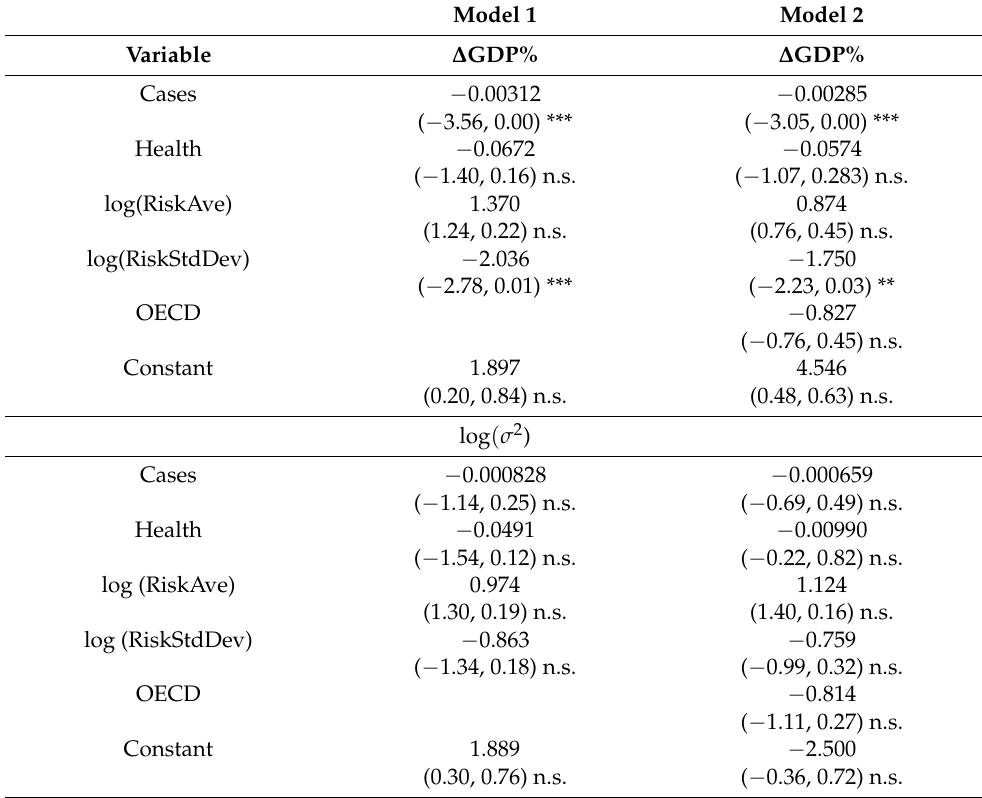
Table 5. Parameter estimate, ( t -statistic, p -value, with its significance in parenthesis), and indicators for the listed model considering heteroscedasticity with COVID-19 economic